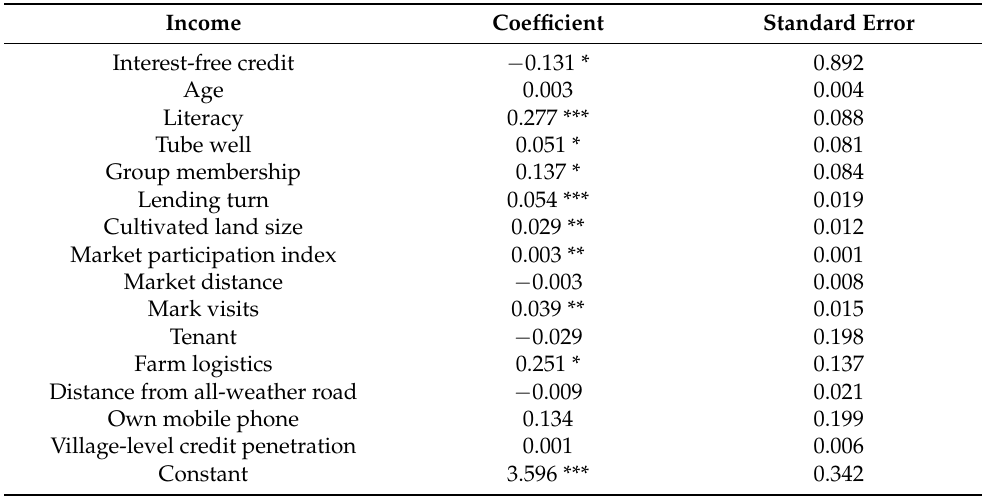
Table A5. Full table of Ordinary Least Square (OLS) estimate of first-period credit and market participation.